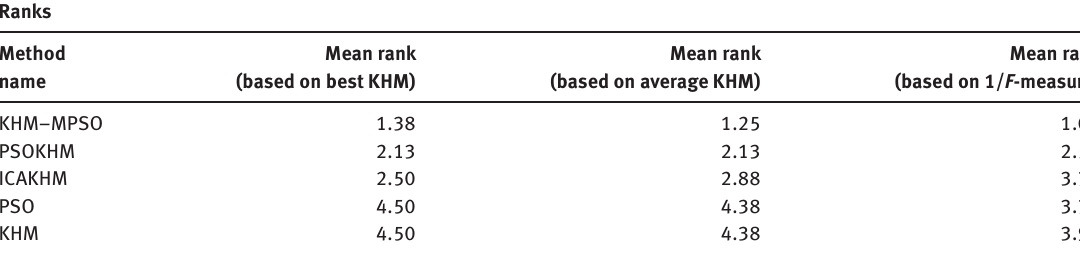
Table 6: Results of Friedman Tests Based on the Best and Average KHM() as well as 1/ F -Measures. Ranks Method